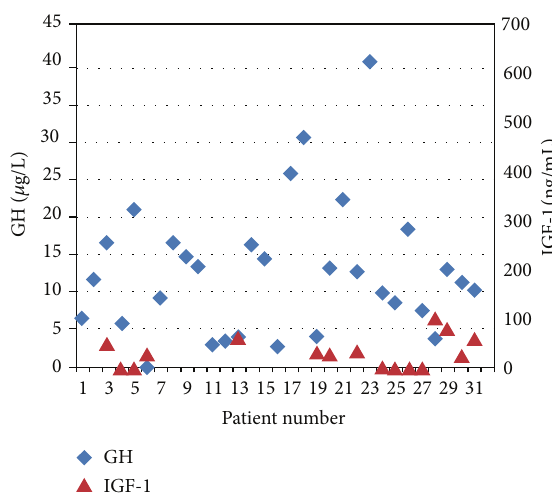
Figure 1: Graph shows rise in GH concentrations whilst the serum IGF-1levelsarelowduringtheepisodesofhypoglycaemiainpatients with